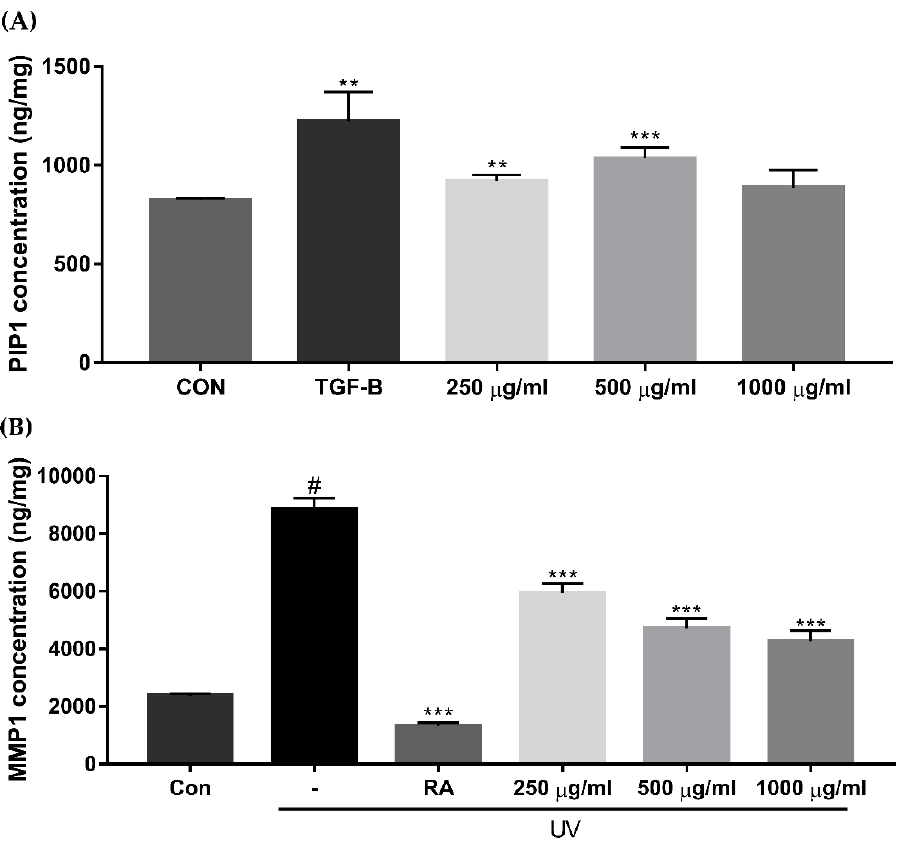
Figure 5. Concentrations of PIP1 and MMP1 in HDF cells according to the ELISA assay. The PIP1 concentration was significantly increased after treatment with 250 µ g/mL and 500 µ g/mL of EverCTP TM (NEWTREE Co., Ltd., Seoul, Korea) and TGF- β compared to the CON ( A ). MMP1 production was induced by 10 mJ/cm 2 of UVB irradiation, and induced MMP1 production was dose-dependently decreased according to the concentration of EverCTP TM treatment ( B ); # p < 0.005, independent samples t -test compared with the CON; ** p < 0.01, *** p < 0.005, independent samples t -test compared with the CON group ( A ) or the UV irradiation group ( B ). TGF- β and RA were used as the positive controls. TGF- β , transforming growth factor-beta; RA, retinoic acid; PIP1, procollagen type I; MMP, matrix metalloproteinase; ELISA, enzyme-linked immunosorbent assay; CON, control; UVB, ultraviolet-B; UV, ultraviolet; HDF, human dermal fibroblast. To measure the elastase activation that increases due to UV light and reactive oxygen species (ROS) during the aging process, an elastase inhibition assay was performed. Ac- cordingly, 1 mM phosphoramidon (PR; Sigma Aldrich) was used as the positive control. Elastase inhibition activity was significantly increased after treatment with EverCTP TM dose-dependently. Compared to the negative control, 250 μ g/mL, 500 μ g/mL, and 1000 μ g/mL of EverCTP TM showed 42.12%, 42.74%, and 48.47% increases in elastase inhibition activity, respectively (Figure 6, p < 0.005).